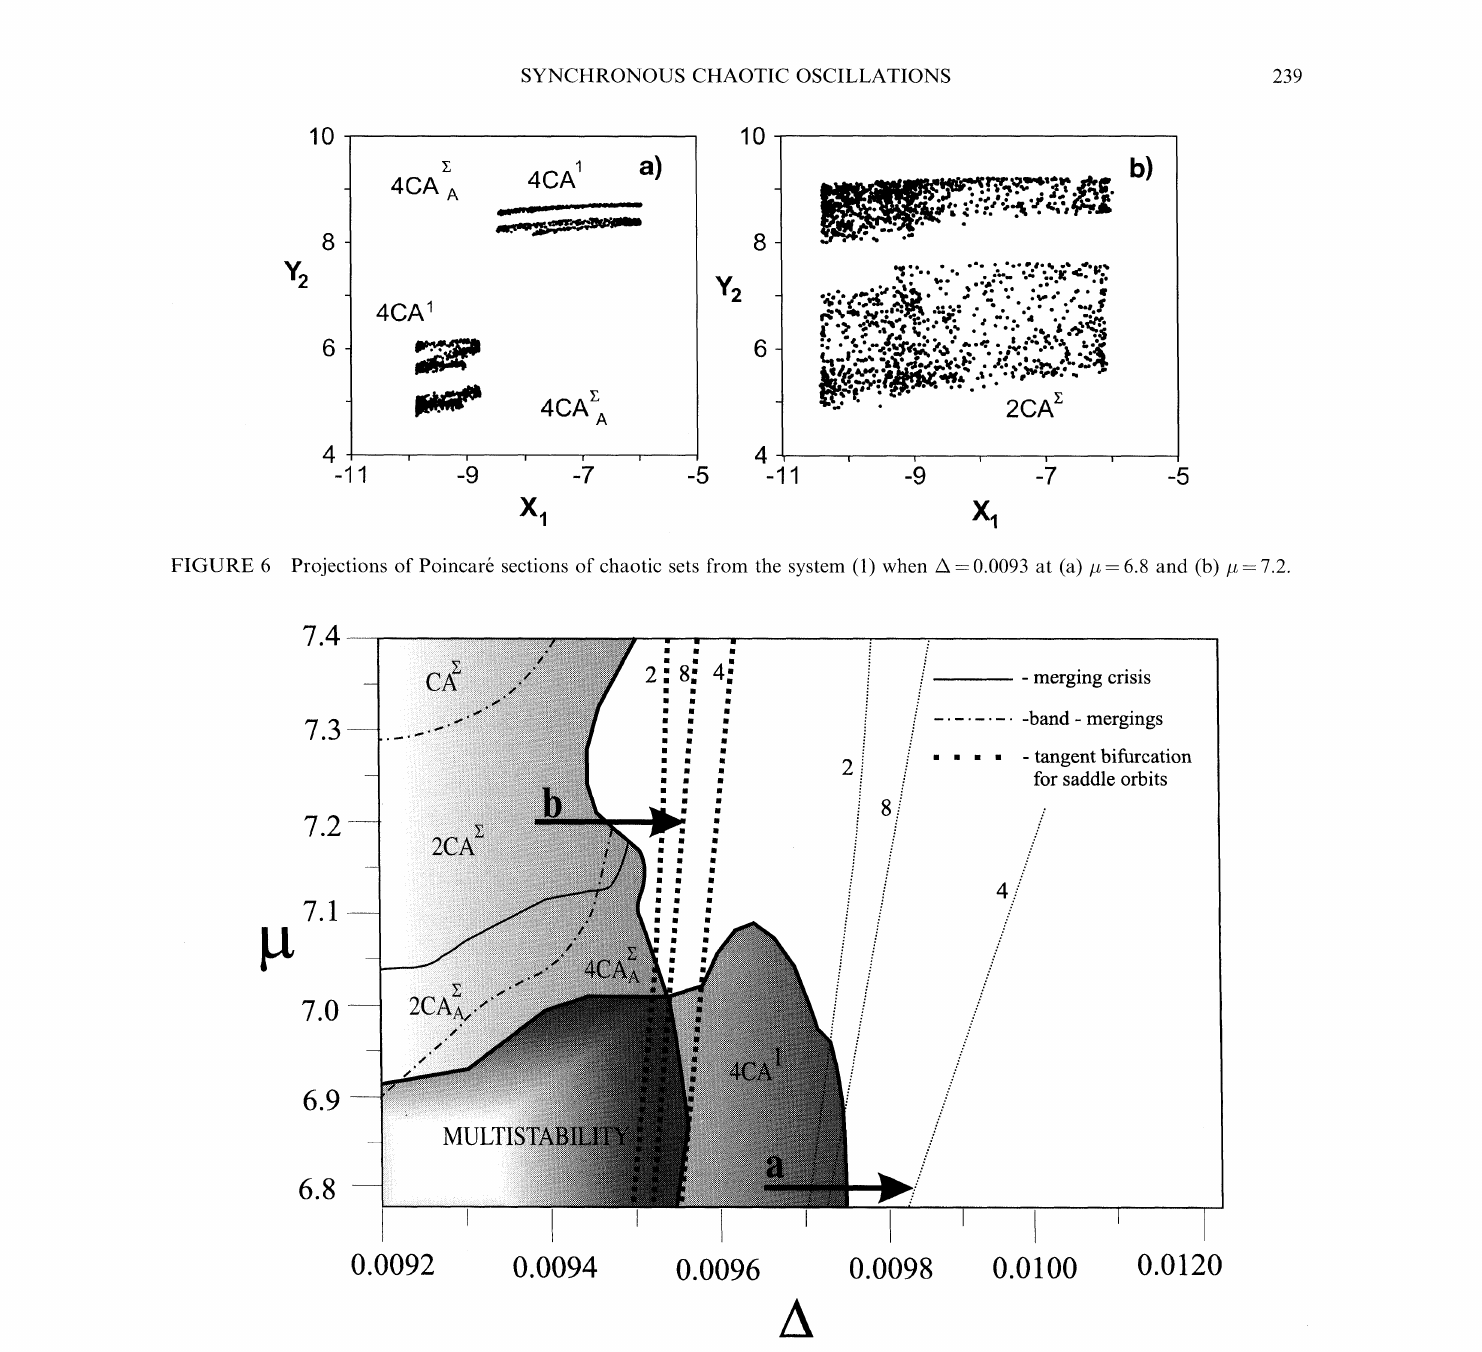
FIGURE 6 Projections of Poincar6 sections of chaotic sets from the system (1) when A 0.0093 at (a) # 6.8 and (b) #-- 7.2.